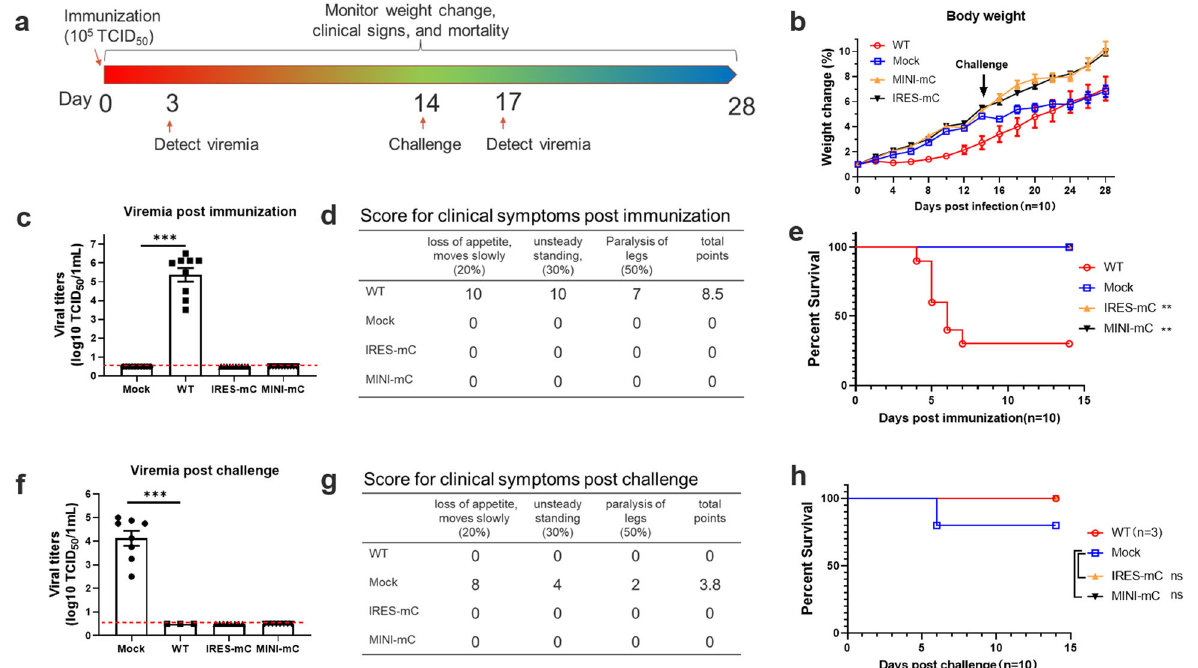
Fig. 5 Single-dose immunization with the CQW1-IRES-mC and CQW1-MINI-mC viruses protected ducklings from lethal challenge by an epidemic TMUV. a Experimental design of the animal experiment. Five-day-old ducklings ( n = 10) were intramuscularly injected with the WT virus, CQW1-IRES-mC mutant virus or CQW1-MINI-mC mutant virus at a dose of 10 5 TCID 50 . The mock group was treated with DMEM. At 14 days post-immunization, the surviving ducklings were challenged with virulent TMUV. b Weight changes of the ducks after immunization (days 1 – 14) and challenge (days 15 – 28). c Viremia after immunization. d Clinical symptoms after immunization. For each item, a score of 1 corresponded to 1 duck exhibiting the corresponding symptom. The total point was calculated as 20% * Item 1 + 30% * Item 2 + 50% * Item 3. e Percentage of survival after immunization. f Viremia after challenge. g Clinical symptoms after challenge. h Percentage of surviving ducklings after challenge. The data are presented as the means and SEMs; signi fi cance was de fi ned by * p < 0.05; ** p < 0.01; *** p < 0.001, and ns indicates no signi fi